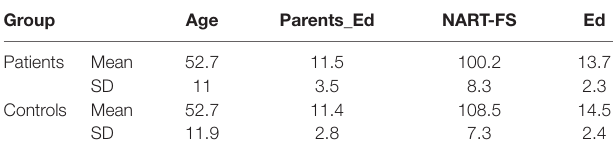
TABLE 1 | Mean and standard deviation of age, parental level of education (Parents Ed), national adult reading test full score (NART-FS) and personal level of education (Ed) in patients and controls.